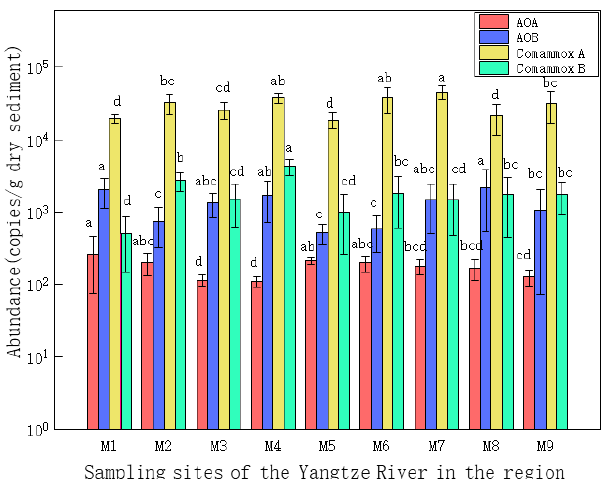
Figure 2. Abundance of AOA, AOB, comammox clade A, and comammox clade B amoA at the TGR area. Different lowercase letters (a–d) indicate a significant difference among different amoA genes at the level of p < 0.05 by Duncan’s test.